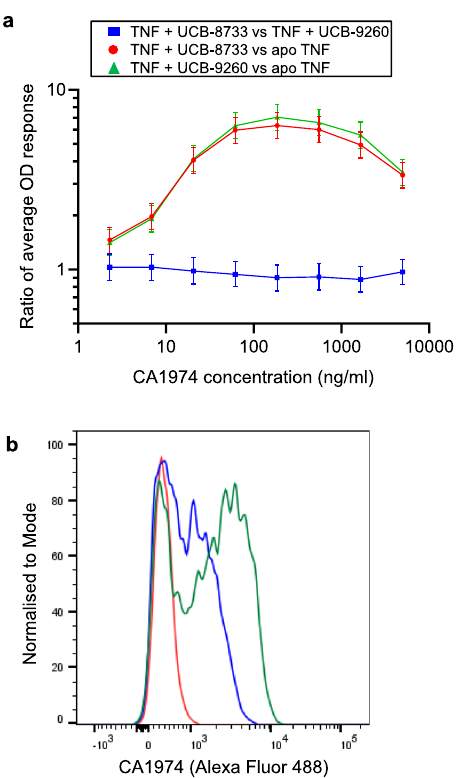
Fig. 1 CA1974 binding to human TNF in complex with small molecule inhibitors. a TNF – small molecule ( UCB-8733 and UCB-9260 ) complex or apo TNF (blue) were captured via TNFR1 which was pre-coated onto a 384- well ELISA plate. CA1974 Fab at a range of concentrations was then added to the plate to detect TNF – small molecule complex. Comparisons are presented as ratios of geometric means (points) and 95% con fi dence intervals for the ratios (error bars), i.e., Comparison of TNF- UCB-8733 complex and TNF- UCB-9260 (blue); Comparison of TNF- UCB-8733 complex and apo TNF (red); Comparison of TNF- UCB-9260 complex and apo TNF (green). b Human TNF- UCB-9260 complex at 25 ng/ml (blue), 250 ng/ml (green) or apo TNF (250 ng/ml) with DMSO (0.4%) (red) was added to HEK-293 Jump In cells expressing human TNFR1. CA1974 IgG at 10 µ g/ml was used to detect TNF – small molecule complex bound to the surface of cells using fl ow cytometry. The binding was revealed using a goat anti-mouse IgG Alexa Fluor 488 secondary antibody. Data is shown for cells present in a gate which de fi nes viable single cells and excludes doublets and other cell debris (Supplementary Fig. 1). Cell count ( y -axis) is normalised to mode. Source data are provided as a Source Data fi